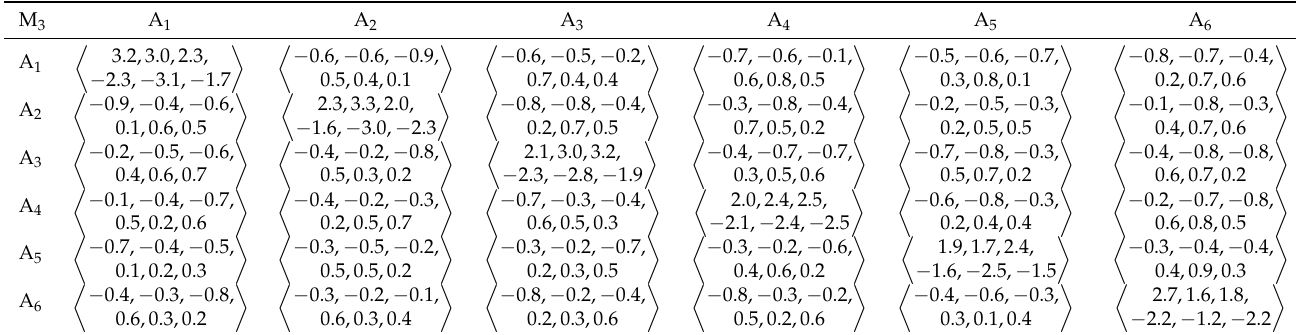
Table 14. Elements of the Laplacian matrix of the BSVNDG, D 3 .